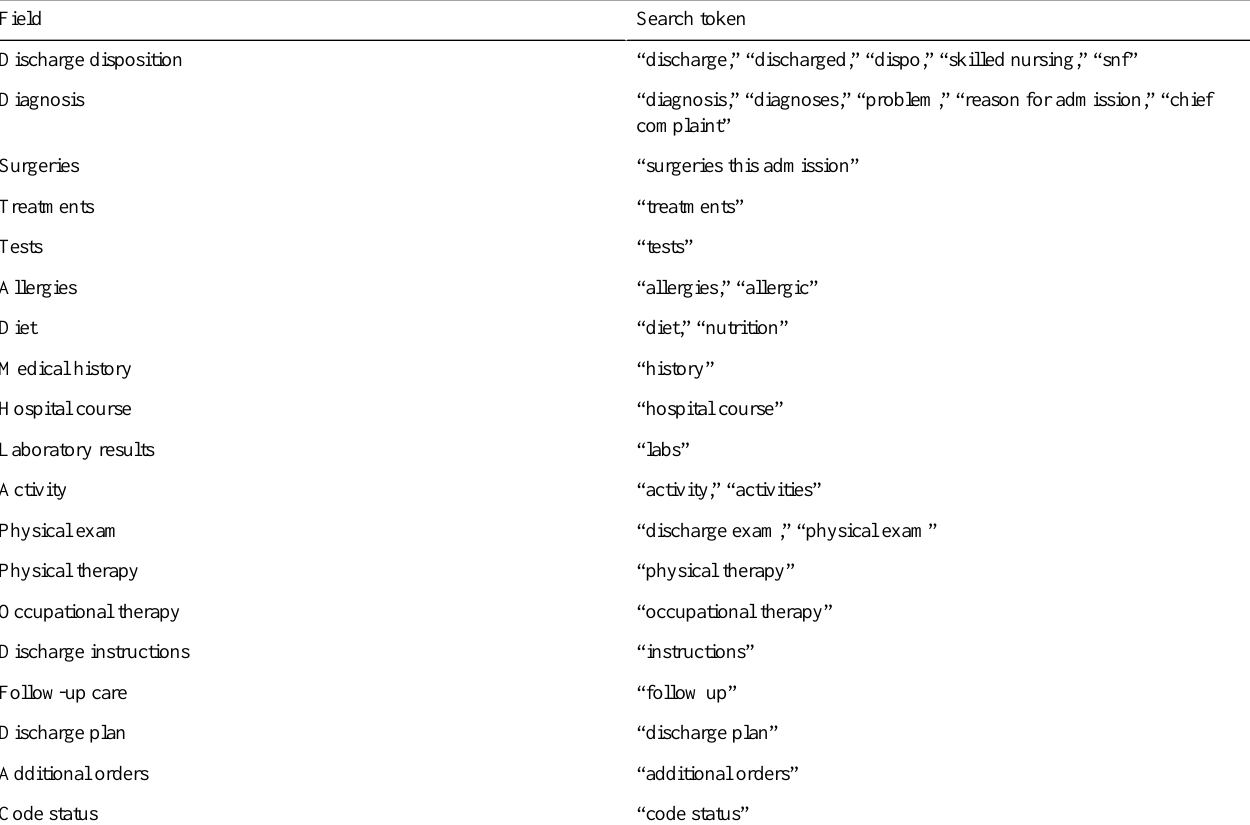
Table 1. Information captured from discharge summaries, grouped in fields, and respective search tokens used in the regular expression.